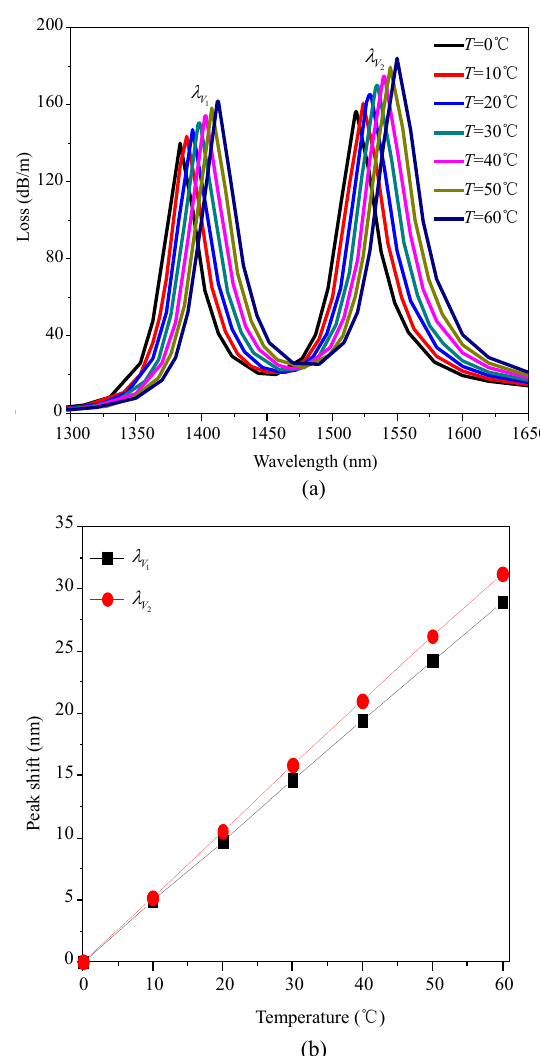
Fig. 9 Loss spectra and the loss-peak shift with different temperature T : (a) the loss spectral shift of LP 01 mode and (b) the relationship between the loss-peak shift and T .